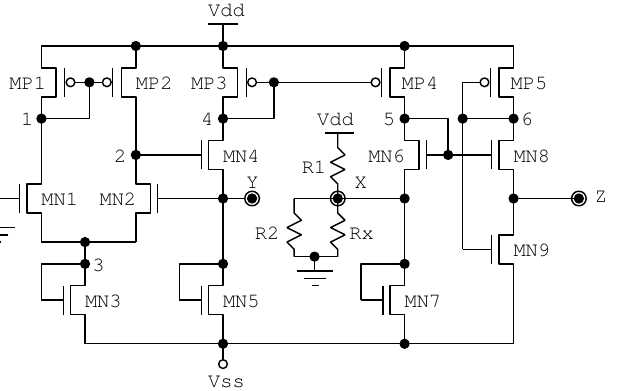
Figure 3. Reference circuit diagram based on [13], including modification of the current sources